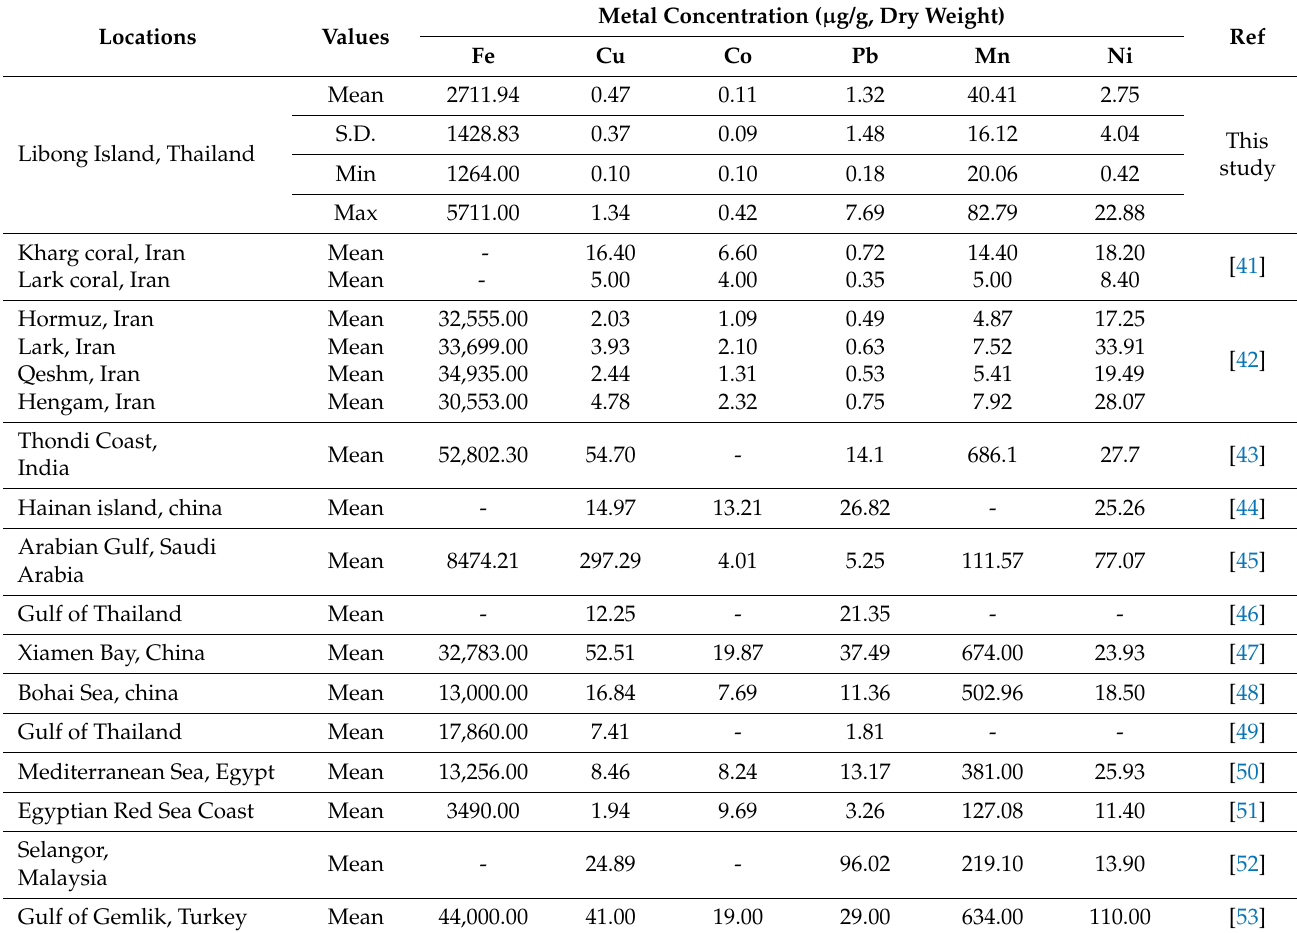
Table 1. Trace metal concentrations in surface sediments ( µ g/g by dry weight) at Libong Island with comparisons to prior published